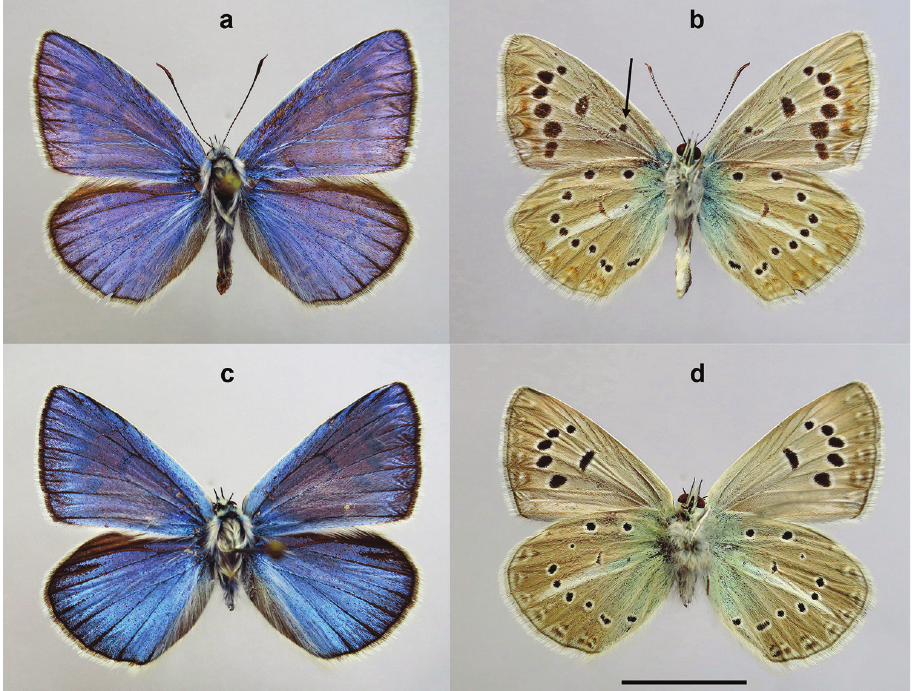
Figure 9. Specimens of Polyommatus ( Agrodiaetus ) australorossicus sp. n. and P . ( A .) shamil . Both sam- ples collected in Gunib (Russia, Caucasus, Daghestan, Gimrinsky Range, 1600-1800 m), 14 August 1997, by A. Dantchenko. a, b upperside ( a ) and underside ( b ) of the holotype of Polyommatus ( Agro- diaetus ) australorossicus sp. n. DK-27-97, n=23; arrow indicates basal black spot c, d upperside ( c ) and underside ( b ) of the paratype of Polyommatus ( Agrodiaetus ) shamil , CCDB-17947_B11, DK-97-18, n=17, 2n=34. Bar = 10